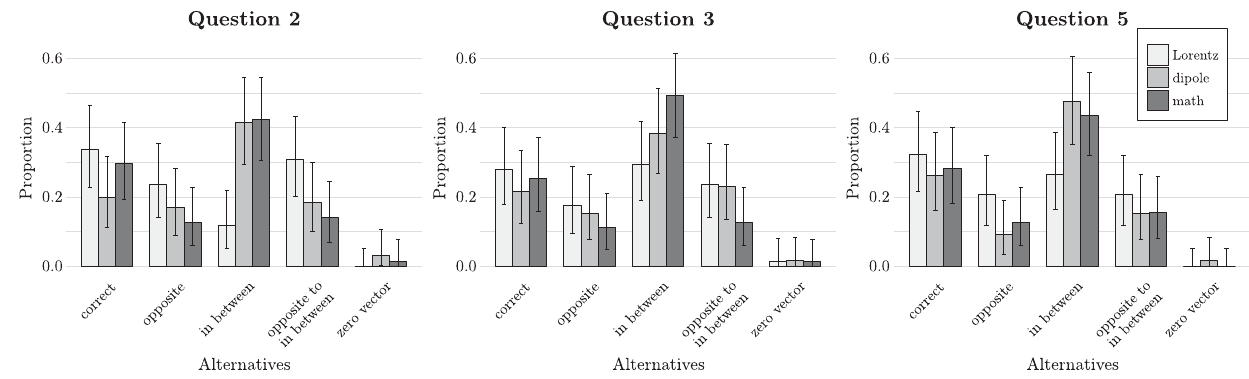
FIG. 4. Students ’ answers on question 2 (left), 3 (middle), and 5 (right) about the cross product of vectors at an angle of 60°, 204°, and 120°, respectively. Error bars indicate the 95% confidence intervals based on the Clopper-Pearson